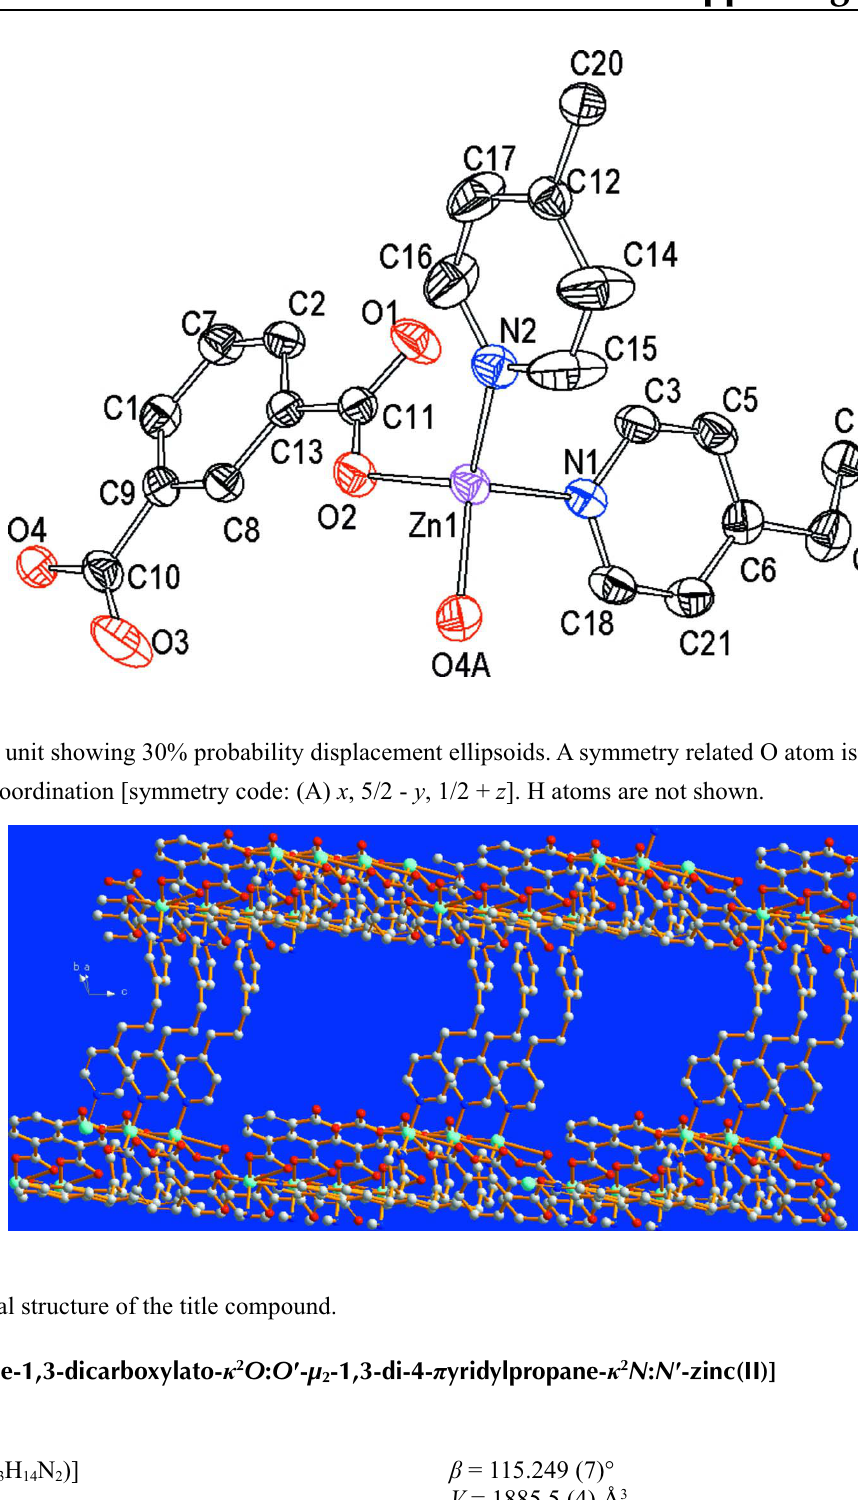
sup-2 Acta Cryst. (2008). E 64 , m386